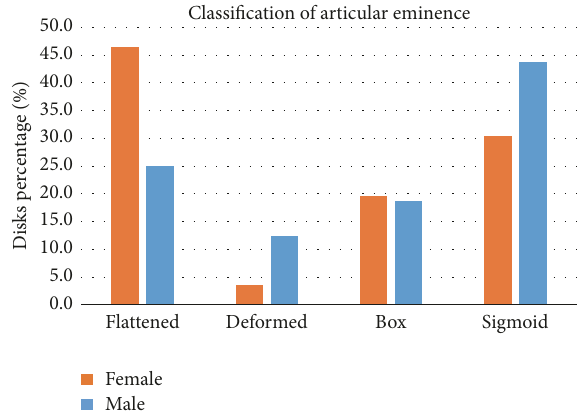
Figure 3: Distribution of the sample according to sex.